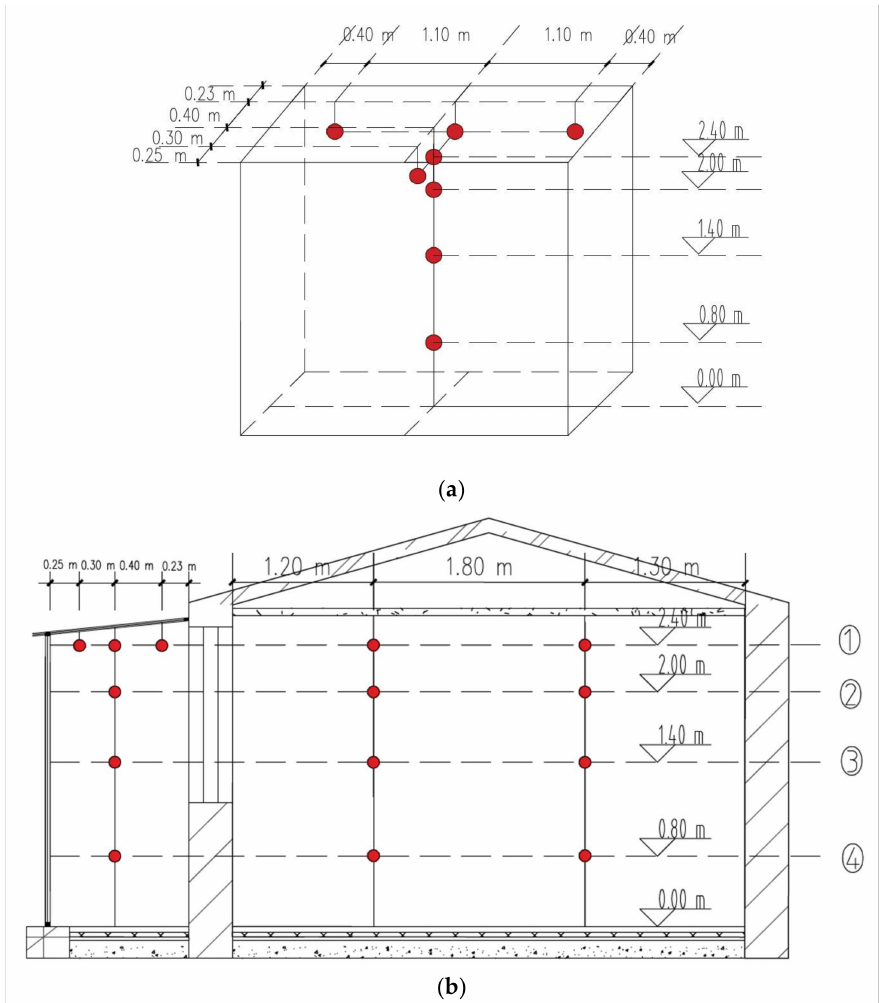
Figure 4. Layout of measuring points in the living lab: ( a ) Layout of measuring points in the attached sunspace; ( b ) Layout of measuring points of the